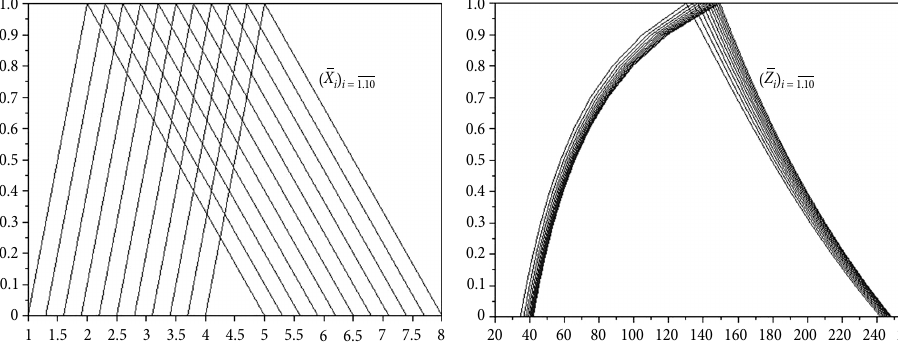
Fig. 3. The effect of the translation of the triangular fuzzy numbers X on the objective function